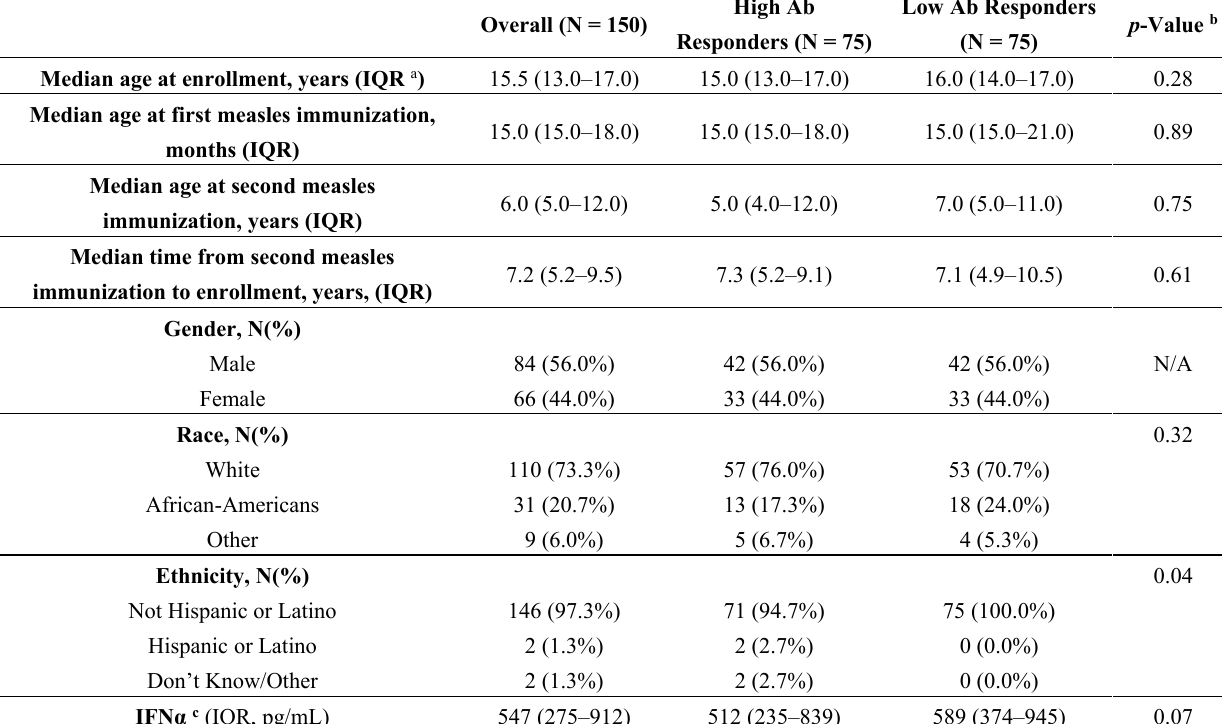
Table 1. Demographics and clinical/immune variables of the study